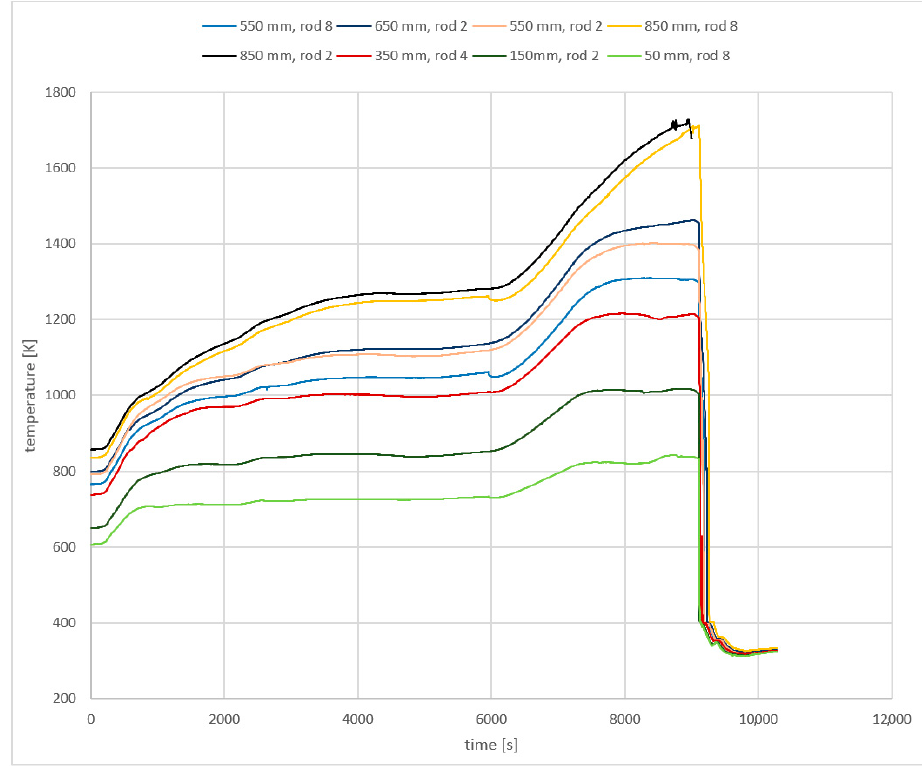
Figure 10. Temperatures measured in the heated part of the bundle and the central ring, 2/2 (axial level, rod) [12].